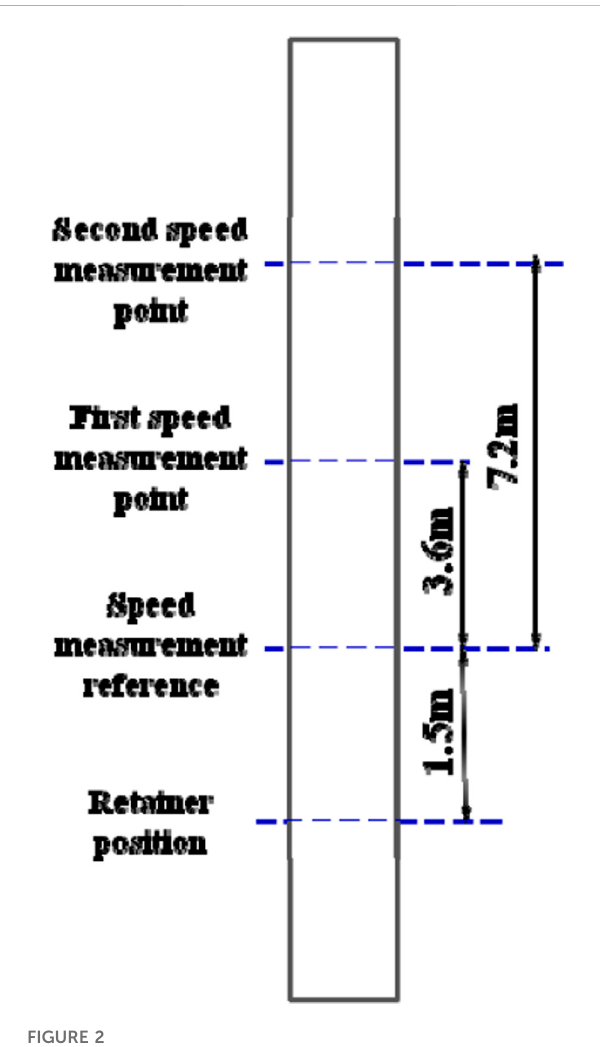
FIGURE 2 Plunger movement measurement points.